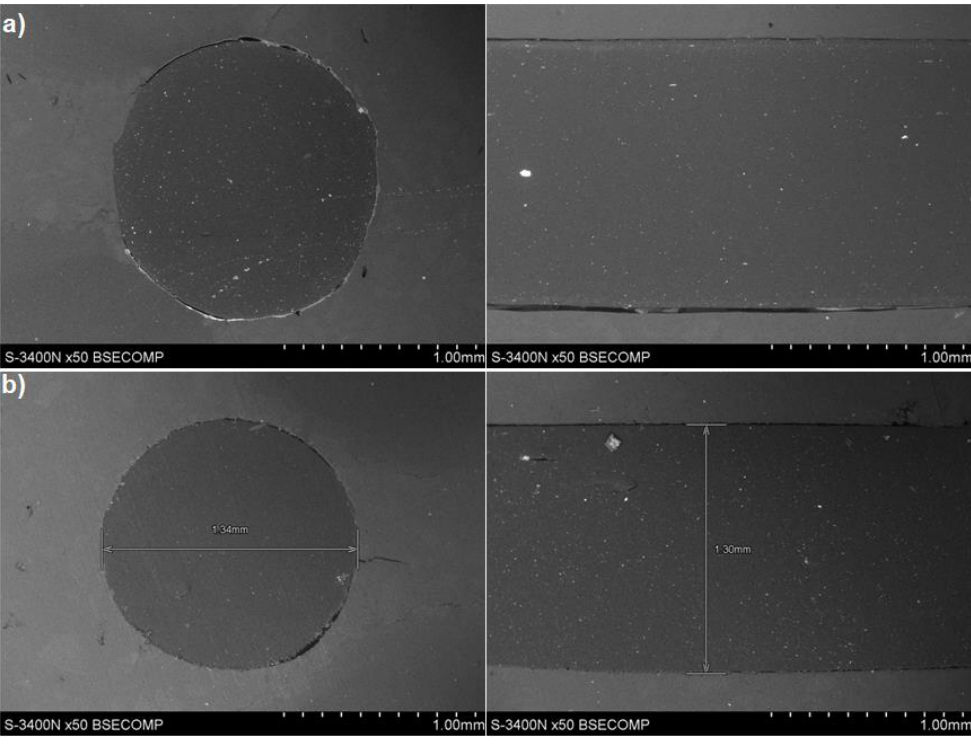
Figure 4. Composite filament microstructure: ( a ) LDPE15, ( b ) LDPE30.